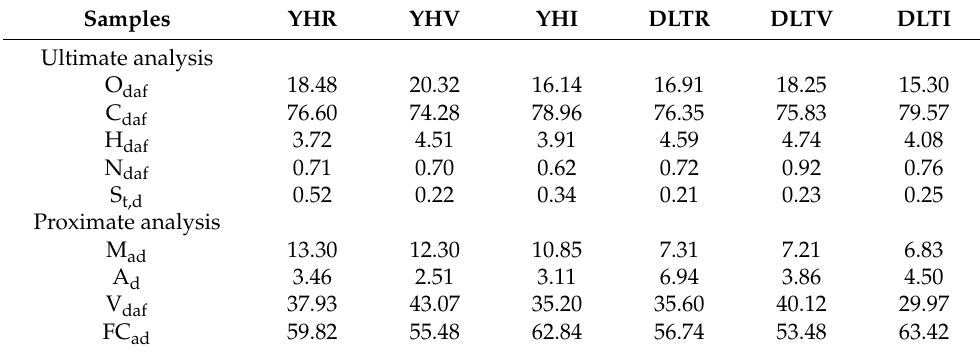
Table 1. Total sulfur, and proximate and ultimate (wt%) analyses of samples.